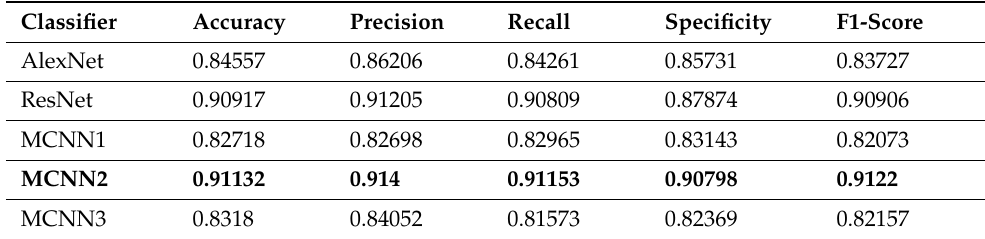
Table 4. Classification results using original (raw) MRIs data.